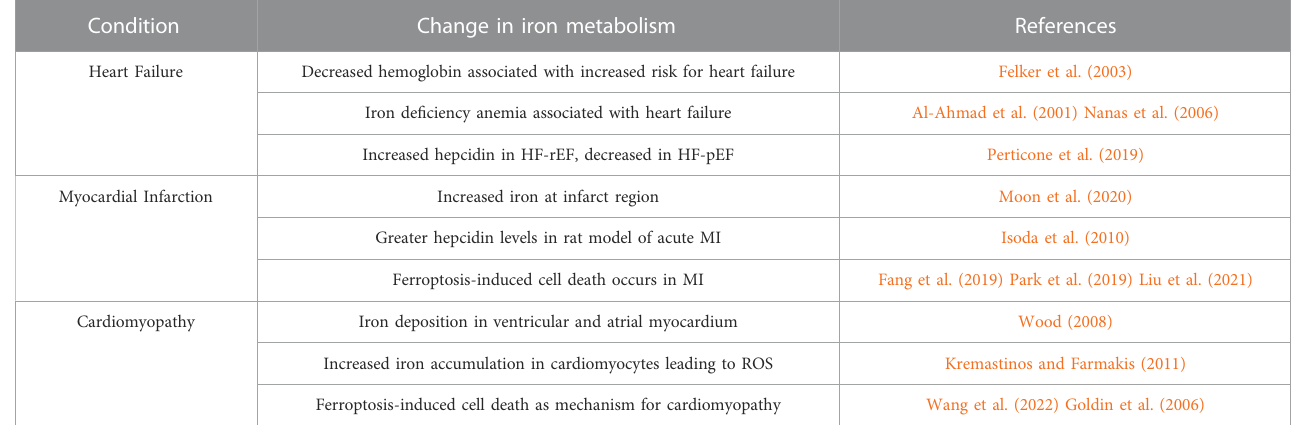
TABLE 3 Evidence for alterations in iron metabolism in cardiovascular